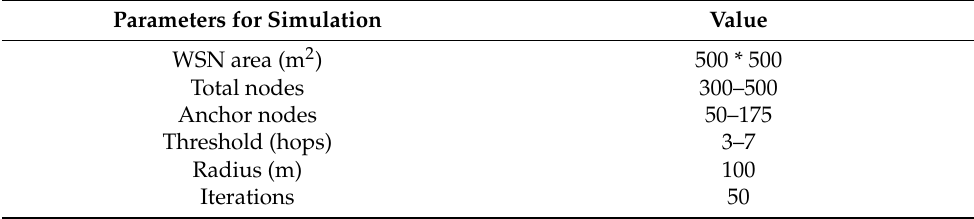
Table 6. Parameter used in